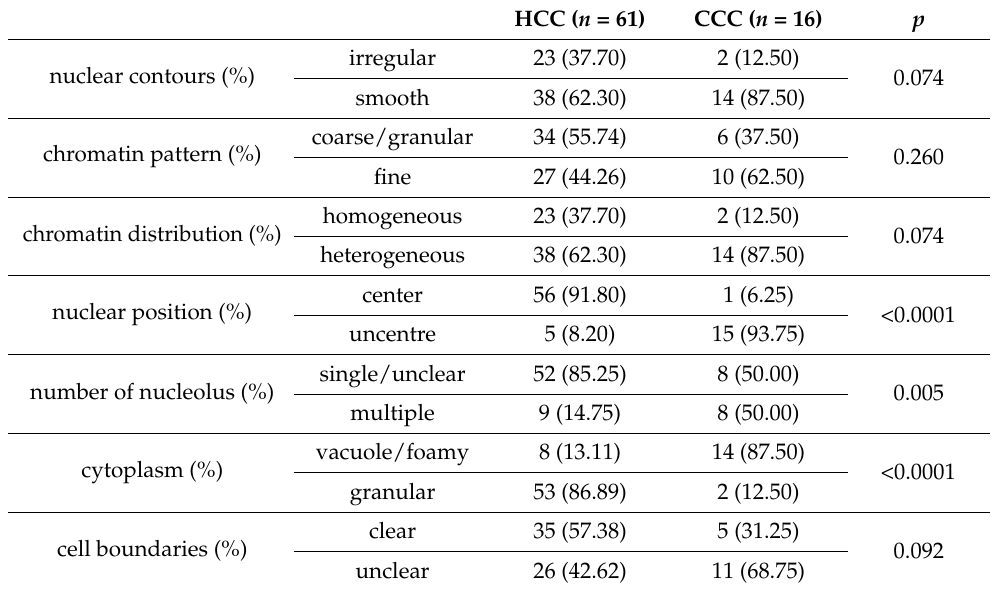
Figure 4. Representative cytological figures of hepatocellular carcinoma (HCC). ( a ) and intrahepatic cholangiocarcinoma (ICC). ( b ) In touch smear specimens (Papanicolaou stain, ×400). HCC cells have round and center-positioned nucleus and granular cytoplasm whereas ICC cells have oval and uncenter-positioned nucleus, multiple nucleolus, and foamy cytoplasm. Table 3. Comparison of Cytological Fndings between ICC and HCC.